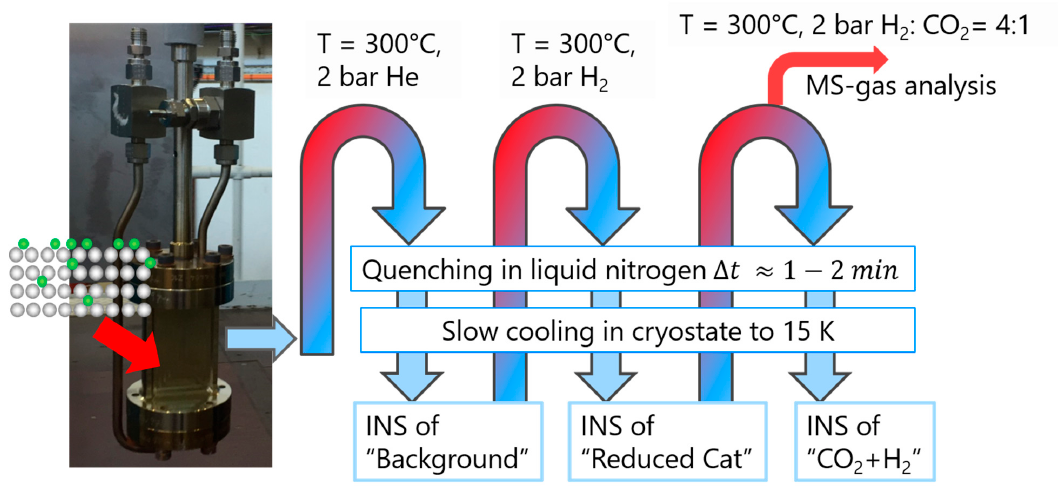
Figure 2. Left: Inconel 718 sample cell specially designed for flow reactions for post-mortem inelastic neutron scattering (INS) [18]. Reduction and methanation takes place at 300 °C in this cell at indicated conditions. The reaction yield is monitored by an attached mass spectrometer. After closing the valves without removing the gases, the cell is quenched to 77 K in liquid nitrogen, and then further cooled down in the cryostat of the neutron beamline (TOSCA).